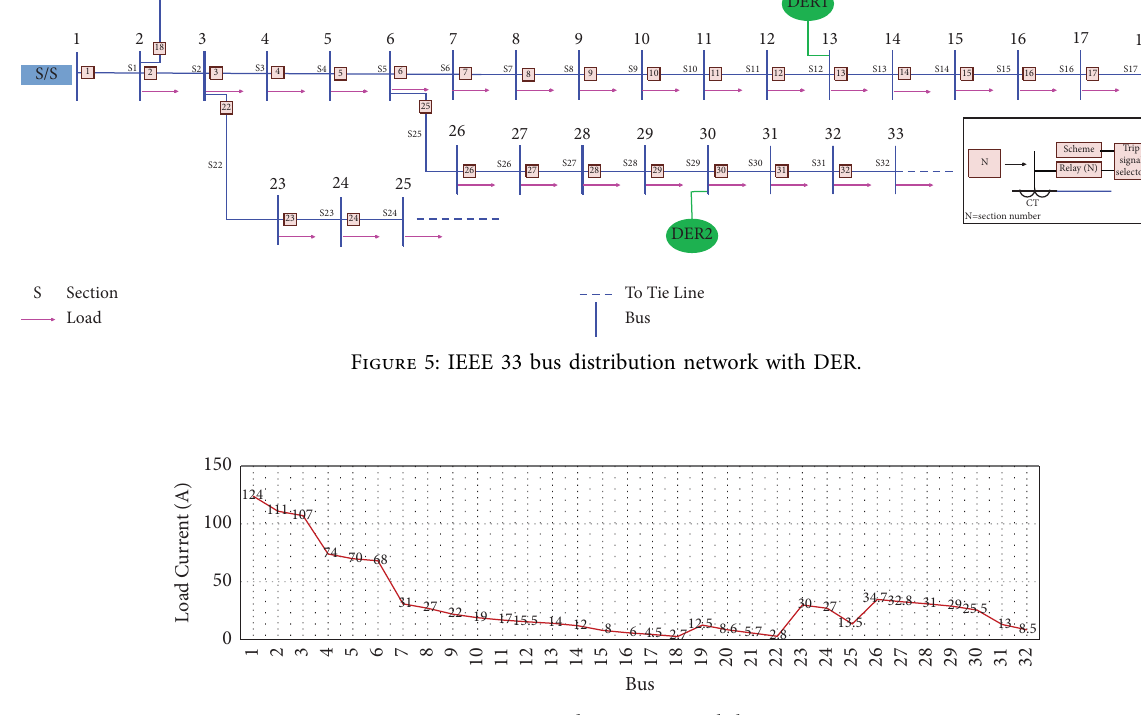
Figure 6: Load current at each bus.